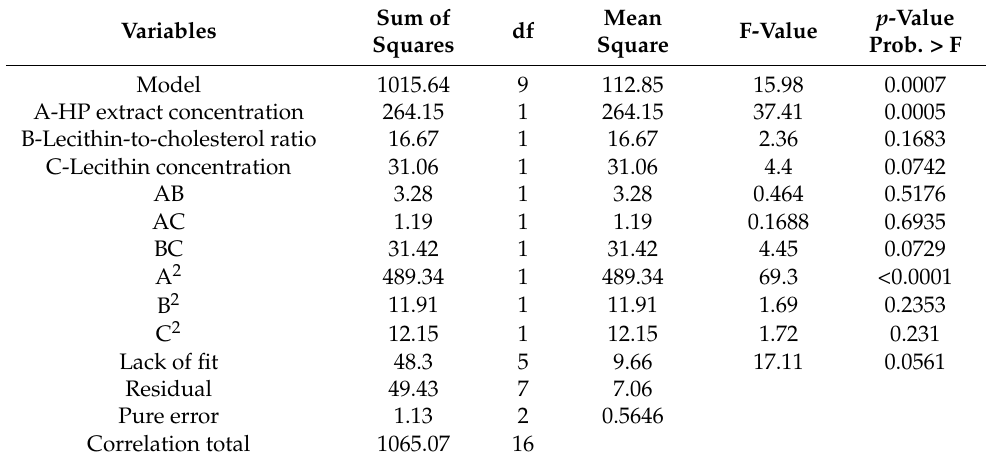
Table 2. Analysis of Variance of Regression